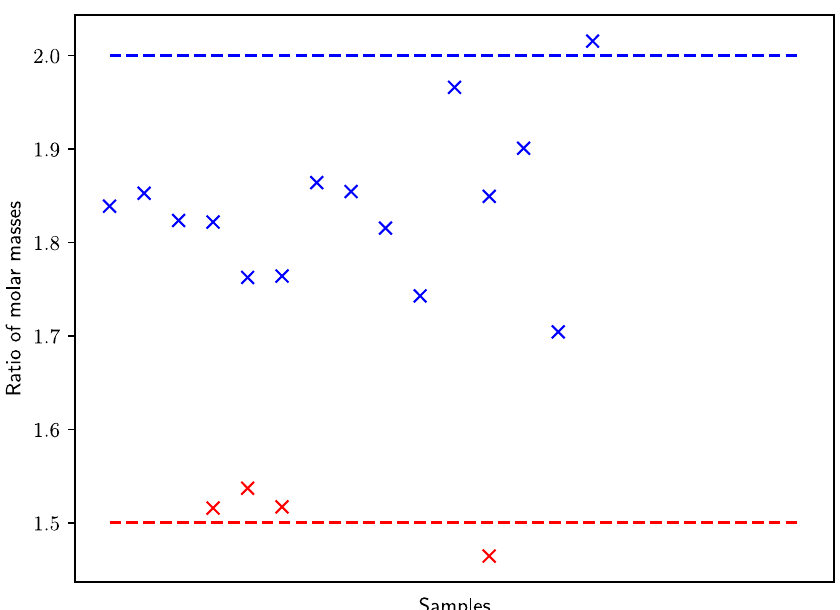
Figure 5. Ratio of molar masses of inflection points for all DnPI samples. Blue points show the ratio of the second inflection point to the first one, while the red points show the ratio of the third inflection point to the second one. Data points that significantly deviate from the expected ratios have been omitted from the analysis according to the consistency criterion of PLP-SEC.